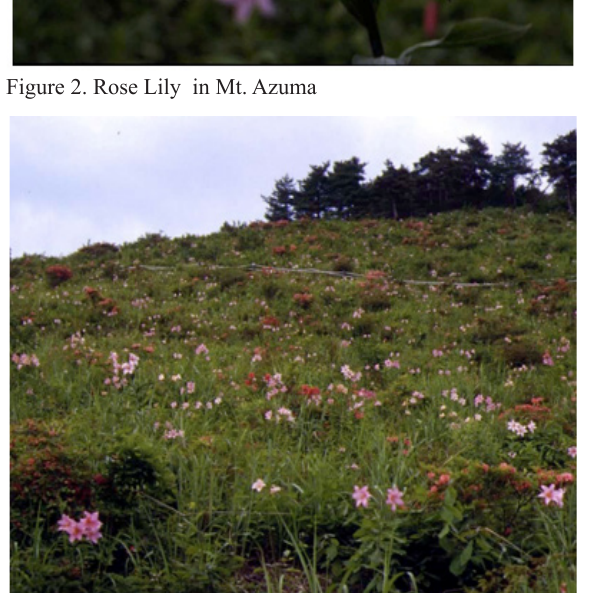
Figure 3. Rose Lily in Atsushio-kano